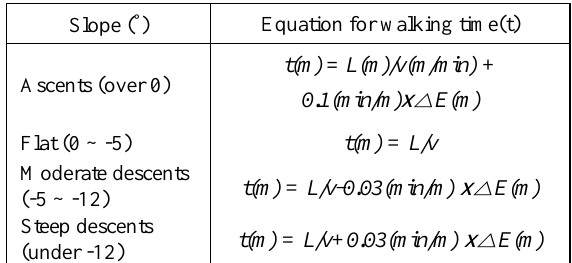
Table 1. Modified Naismith-Langmuir